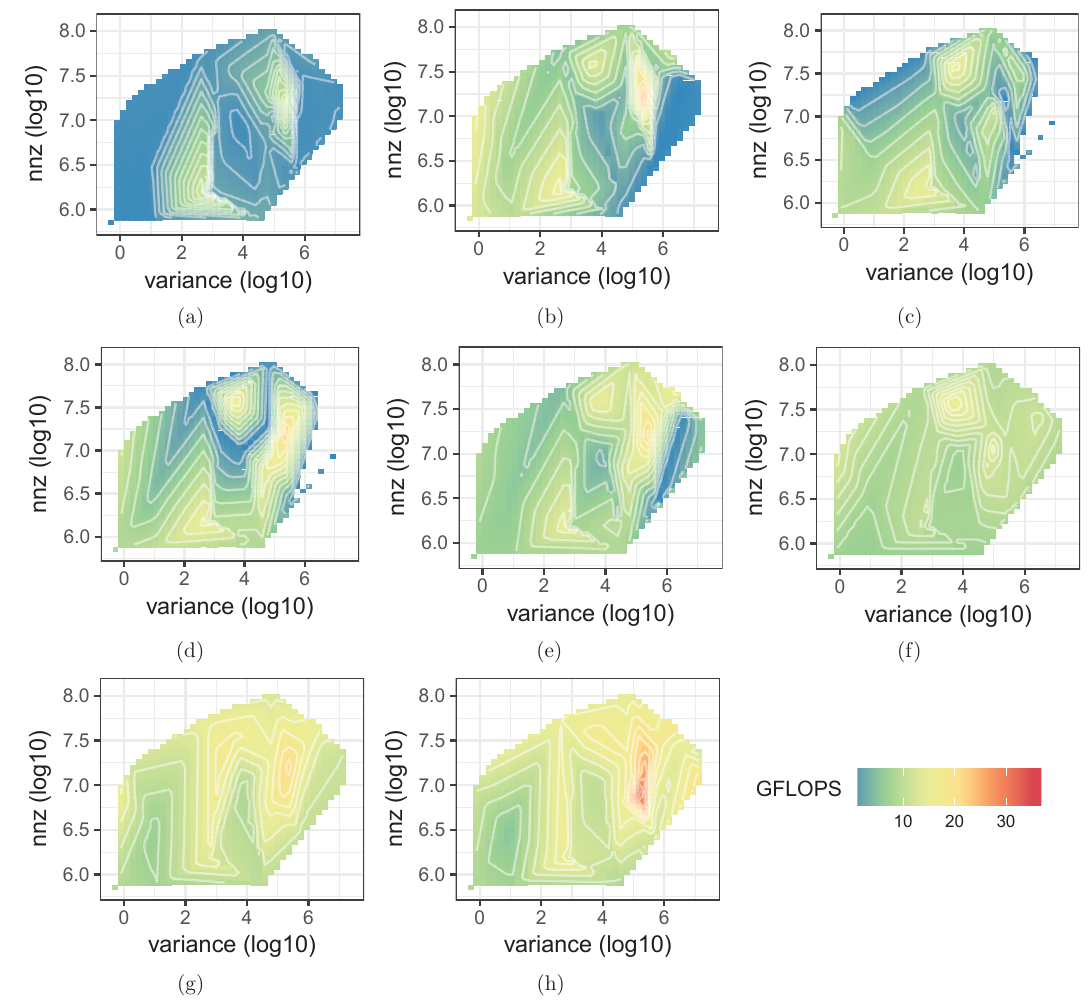
Figure 13. Throughout with respect to npr variance and nnz for ( a ) BSR; ( b ) SELL-P; ( c ) WPK1; ( d ) WPK2; ( e ) CSR; ( f ) HYB; ( g ) CSR5; and ( h )